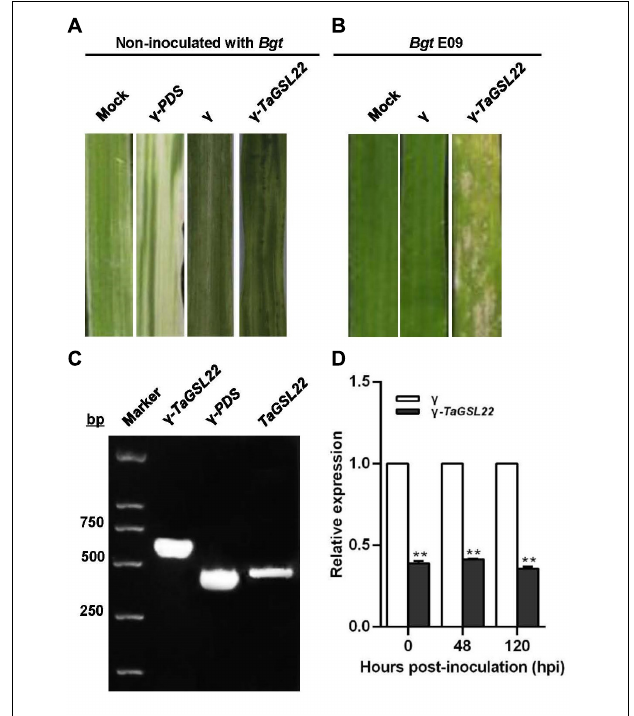
FIGURE 5 | Functional assessment of TaGSL22 in the wheat– Bgt interaction by gene silencing. (A) The leaf phenotype of successful virus infection; photographs were captured 12 days post-inoculation (dpi); mock: leaves inoculated with water; γ - PDS : transcripts of α , β , γ - PDS plasmids inoculated on leaves; γ : transcripts of α , β , γ plasmids inoculated on leaves; γ - TaGSL22 : transcripts of α , β , γ - TaGSL22 plasmids inoculated on leaves. (B) Disease phenotypes of the leaves pre-inoculated with BSMV: γ then the avirulent E09 Bgt race; mock: the leaves were only inoculated with Bgt . Photos were taken at 10 dpi. (C) PCR amplification of γ - TaGSL22 , γ - PDS , and TaGSL22 from corresponding leaves. (D) Assessment of TaGSL22 silencing efficiency. Relative gene quantification was calculated by the comparative (cid:49)(cid:49) CT method, and data were normalized to the expression level of the wheat elongation factor TaEF-1 α . ** indicates a significant difference at P < 0.01 from the control group ( γ ) by Student’s t -test. Error bars represent SEM